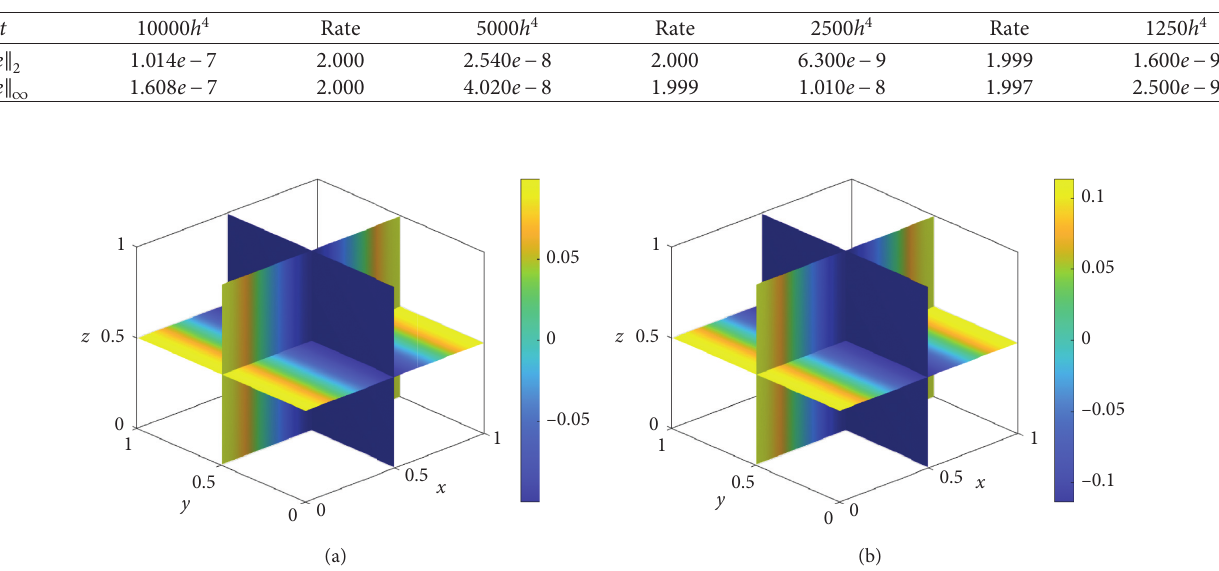
Figure 6: (a, b) The initial condition and the reference solution at t � 10 6 h 4 , respectively. Table 7: Errors and convergence rates for the numerical results of the LSS at the final time T � 10 6 h 4 . Here, h � 1/128 is used. Δ t 10000 h 4